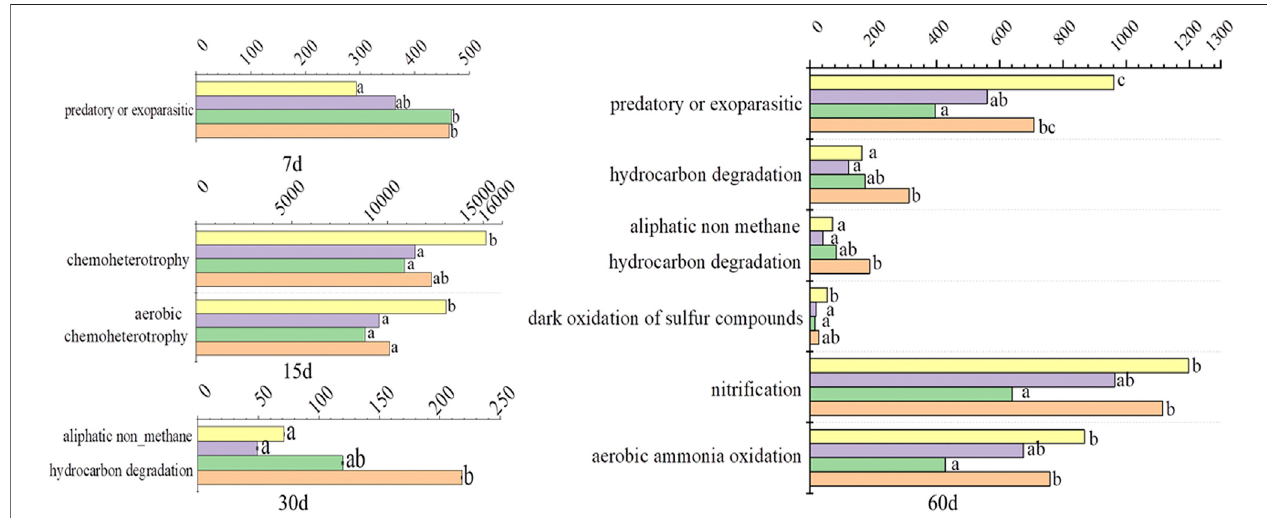
FIGURE 3 | Bacterial functions predicted by FAPROTAX. Letters “ a ” and “ b ” on the right of the columns mean signi fi cance of difference ( p < 0.05).